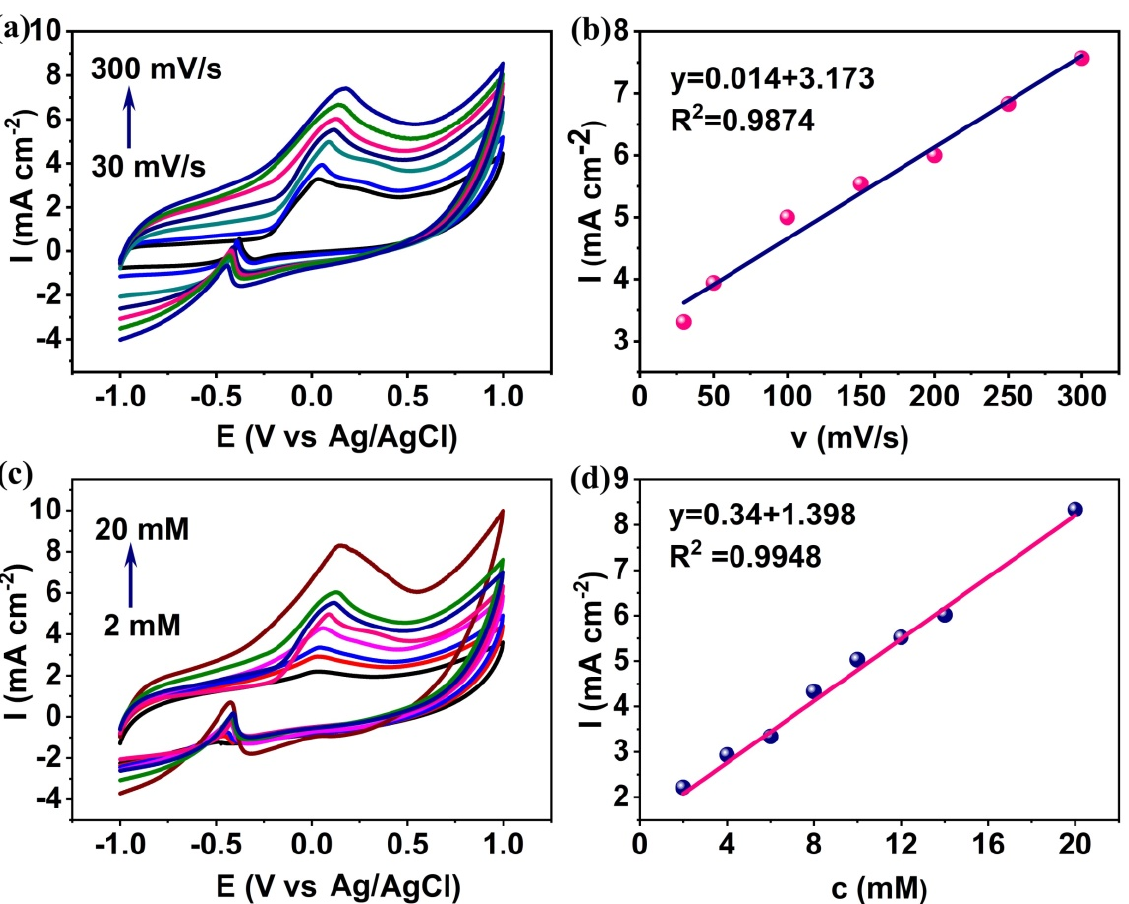
Figure 6. ( a ) CVs of Nafion/GC-Pd/rGO-0.5% electrode at different scan rates in 10 mM formalde- hyde in 0.5 M NaOH. ( b ) Linear plots of the oxidation currents versus scan rates. ( c ) CVs of Nafion/GC-Pd/rGO-0.5% electrode at different concentration of formaldehyde (2 mM to 20 mM) rates in 0.5 M NaOH. ( d ) The relationship between oxidation current of formaldehyde and the concentration of formaldehyde. Table 1. The comparison of electrochemical behavior for formaldehyde oxidation from the present work with previous reports.